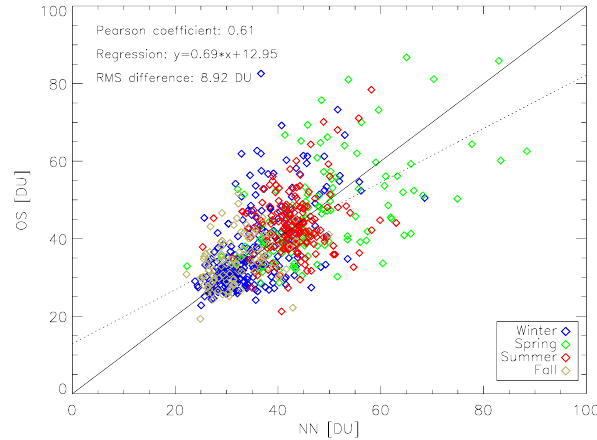
Fig. 2. General scheme, including topology, of the OMI-TOC NN algorithm.